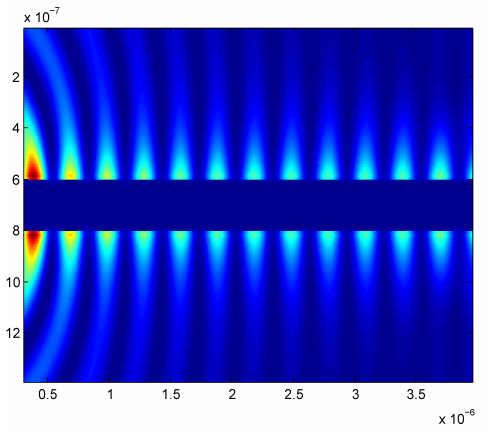
Figure 3: Snapshot of the instantaneous magnitude of the electric field strength in and around the golden strip.